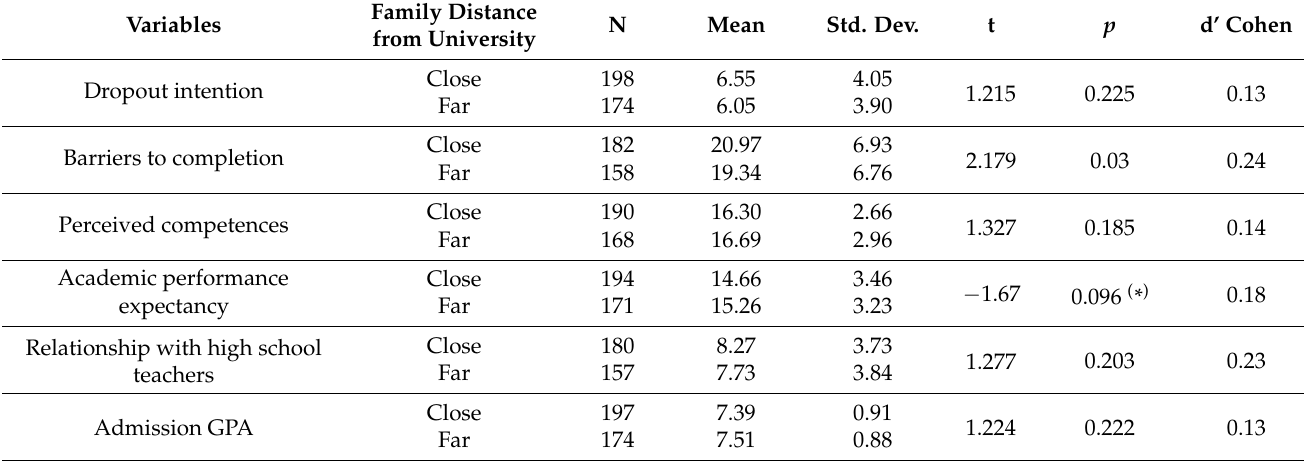
Table 4. Differences related to the distance between the family residence and the university’s location (H4f).